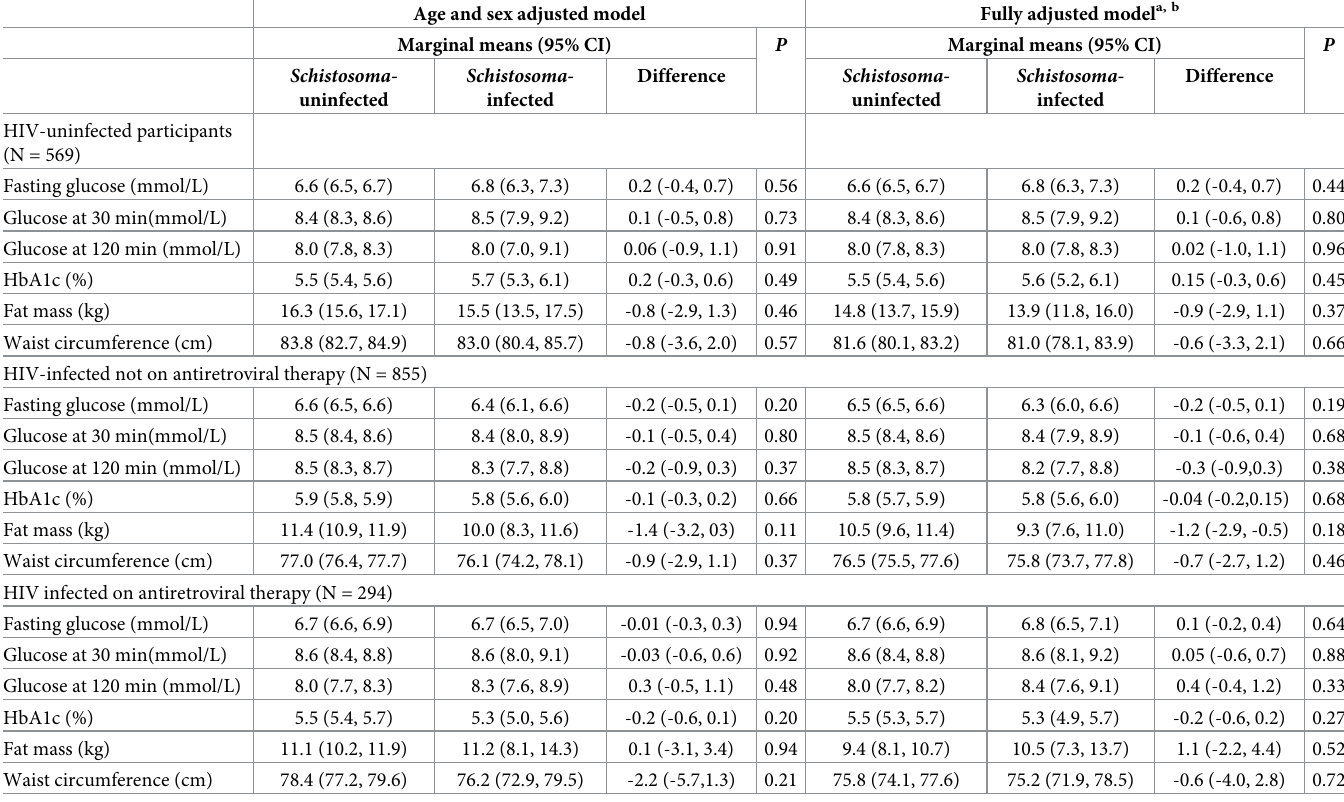
Table 4. Analysis of association of Schistosoma infection with glucose, HbA1c, fat mass, and waist circumference by HIV treatment